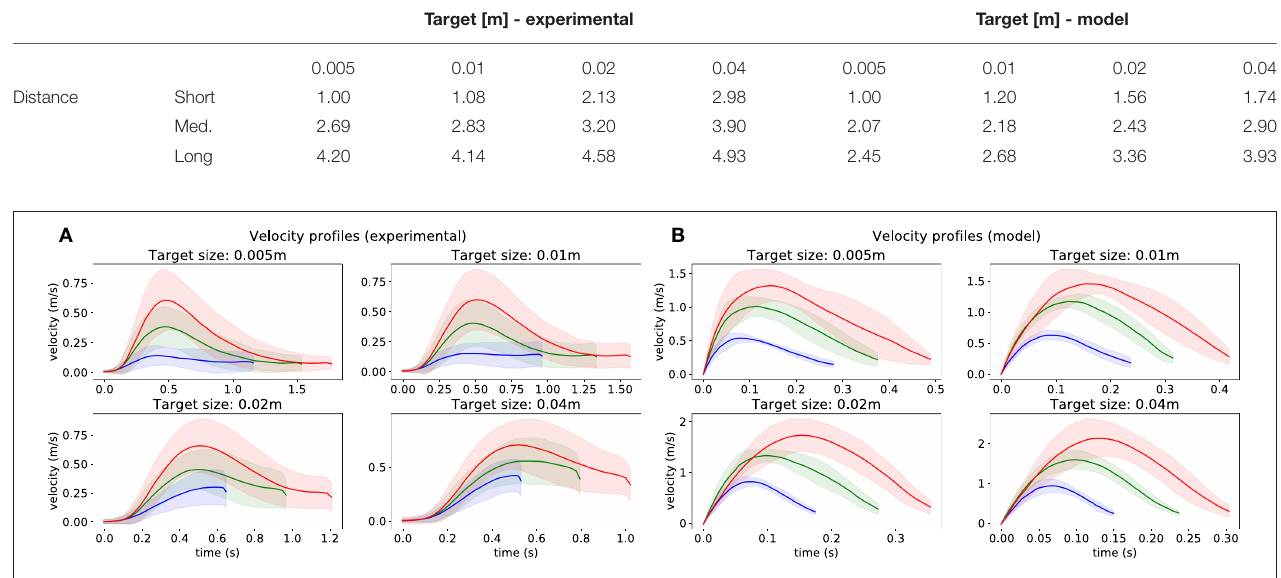
FIGURE 2 | Velocity profiles obtained from 1,500 trajectories starting from 15 points (see Figure 5B ), for each target size. (A) recorded from subjects. (B) obtained from the model. The color of lines depends on the distance between the initial point and the